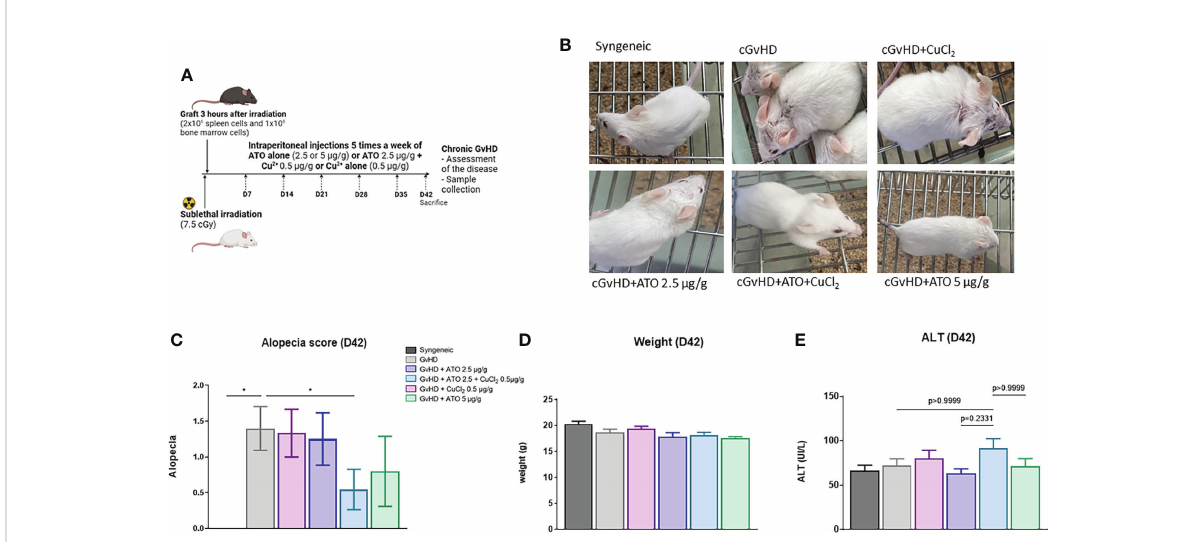
FIGURE 4 ATO and Cu 2+ affect the clinical features of cGvHD in mice. (A) Schematic representation of the experimental induction of sclerodermatous cGvHD in mice. Receiver female (H2 d ) BALB/c mice were irradiated with 750 cGy and grafted intravenously with 2x10 6 splenic cells and 1x10 6 bone marrow cells from male (H2 d ) B10.D2 mice. Mice were monitored for survival, weight, and clinical signs of cGvHD for 42 days (day of sacri fi ce). (B) Photographs on day 42, showing alopecia during the development of cGvHD: mouse from the syngeneic group control, mouse from the cGvHD group control (PBS), mice from the cGvHD group treated by CuCl 2 alone (0.5 µg/g), mice from the cGvHD group treated by low concentration of ATO (2.5 m g/g) + CuCl 2 (0.5 m g/g) or ATO alone at 2 concentrations (2.5 and 5 m g/g). (C) The alopecia score was calculated based on the number of mice with alopecia noted by different grades and multiplied by the number of mice with alopecia at day 42. (D) Mice weight at day 42. (E) Levels of serum alanine aminotransferase (ALT) in the different experimental groups at day 42. *p<0.05. The results for each group are the mean of the measurements obtained per mouse: syngeneic (n = 7); cGvHD (n = 10); cGvHD-Cu (n = 6); cGvHD- ATO 2.5 µg/g (n = 8); cGvHD-ATO-Cu (n = 11); cGvHD-ATO 5 µg/g (n =